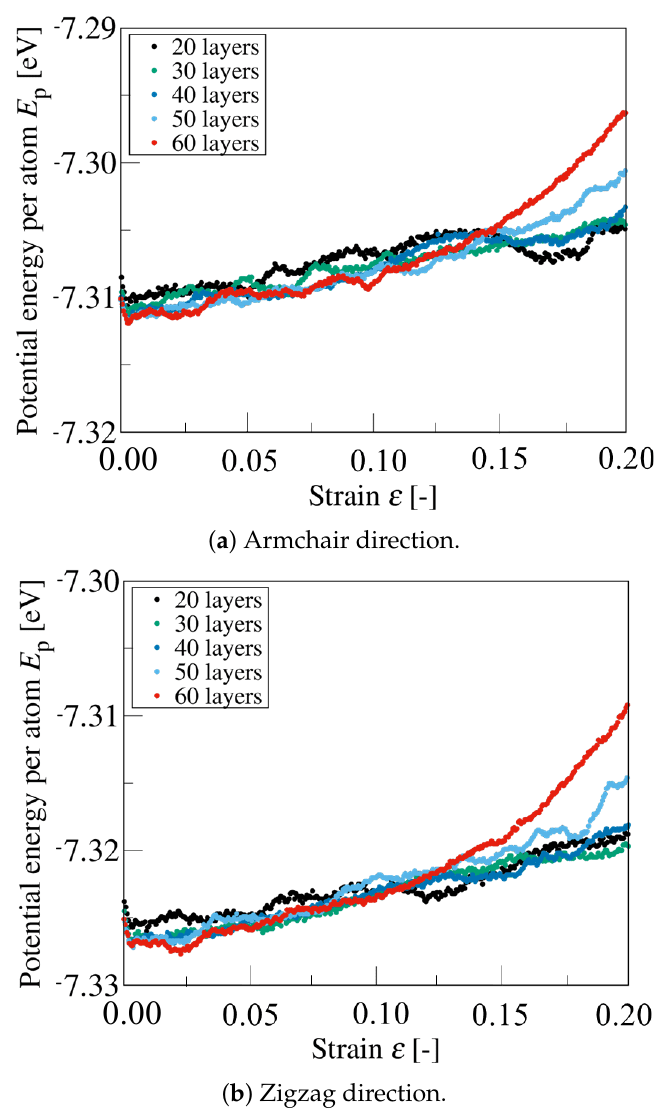
Figure 10. Relationship between potential energy per atom and compressive